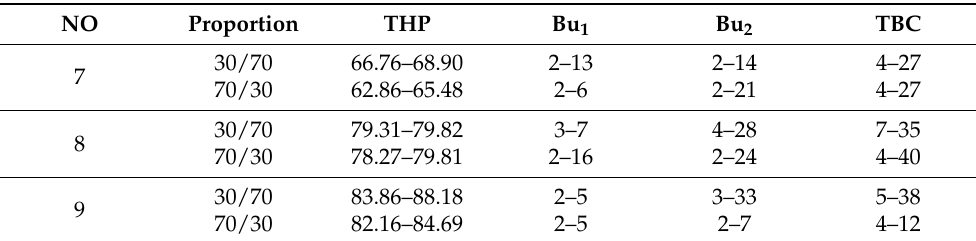
Table 1. Throughput and buffers capacity